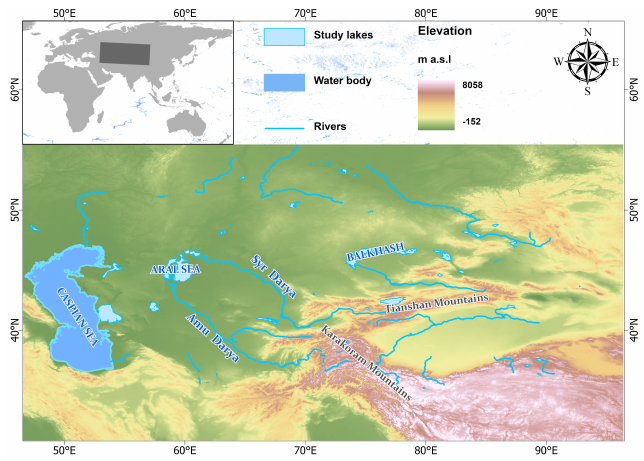
Figure 1. Locations of selected lakes in Central